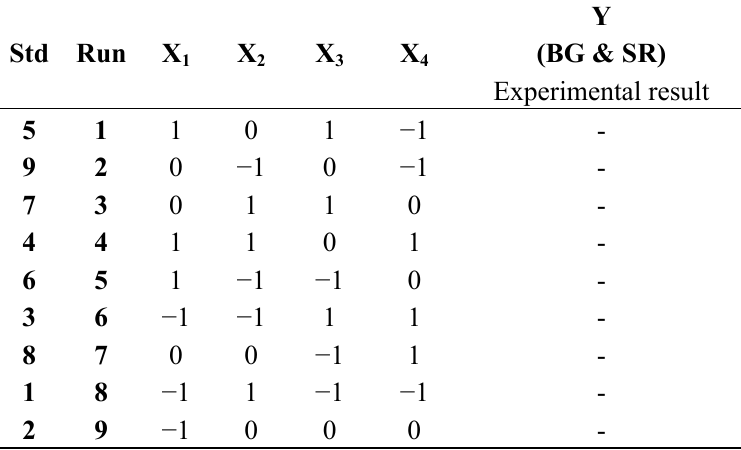
nanocrystalline thin film deposition 2